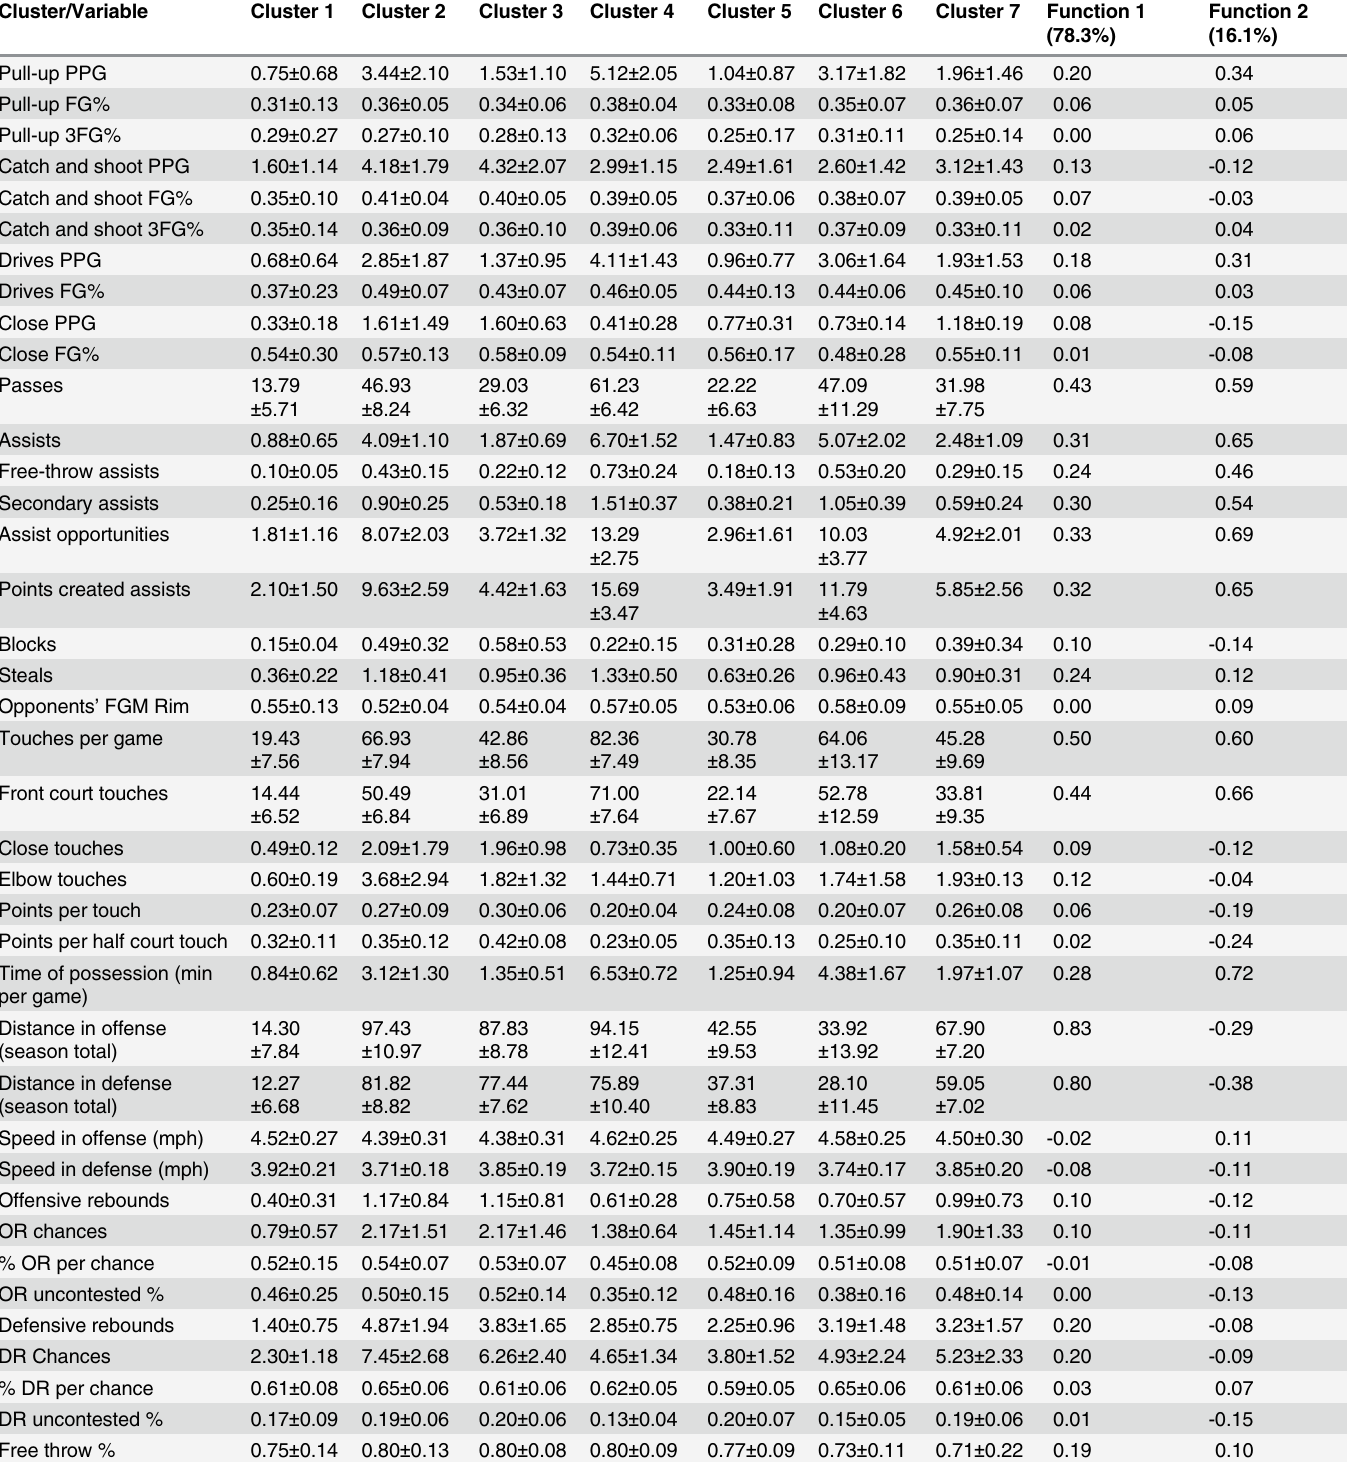
Table 2. Means, standard deviations and structure coefficients from the obtained model of clusters. The variables expressed as counts are averages per